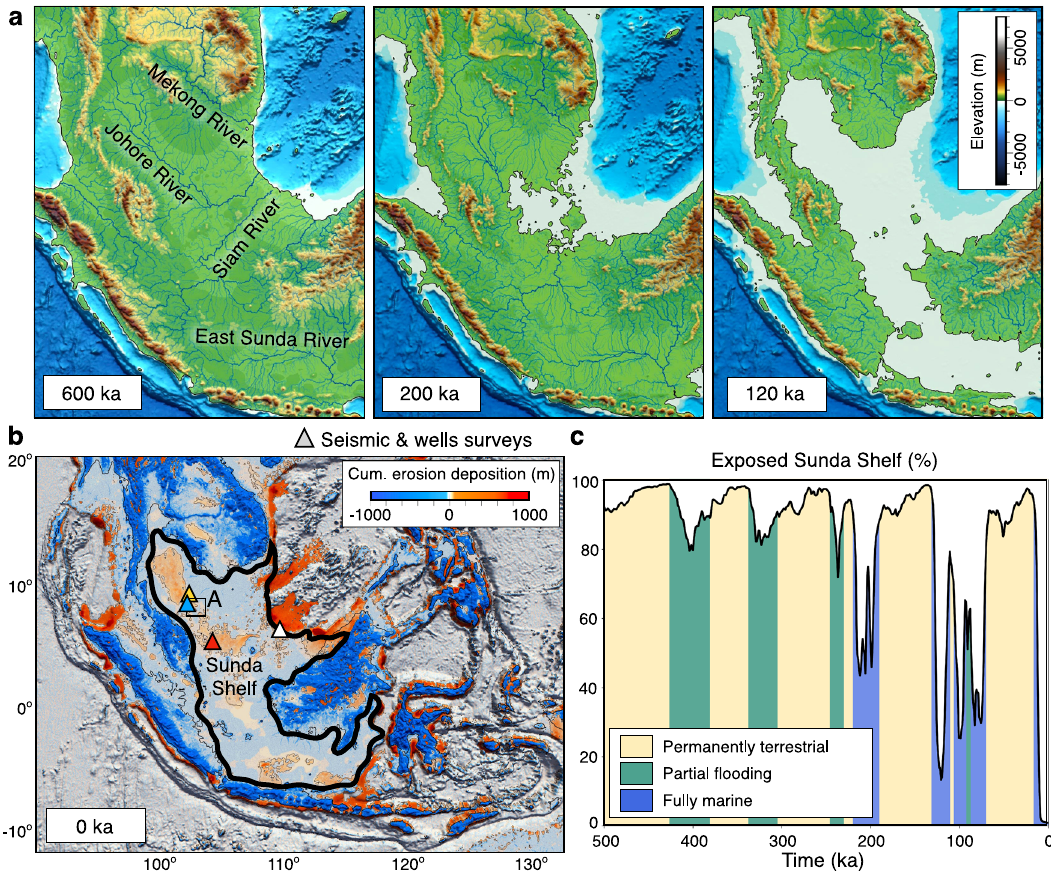
Fig. 1 Simulated landscape evolution, sedimentation and Sunda Shelf fl ooding history under tectonic, eustatic and rainfall forcing conditions. a Outputs showing simulated physiography changes for scenario 5 (Supplementary Table 2) induced by spatially variable tectonics (Supplementary Fig. 1b), eustatic (sea level 37 ) and atmospheric (precipitation 40 ) forcing. b Sunda shelf extent prior to 400 ka is delineated by the black contour. Cumulative erosion (blues) and deposition (reds) map obtained after calibration of landscape evolution parameters from subsurface data (seismic surveys and boreholes 41 – 44 , see Methods). c Subaerial exposure of the shelf is calculated at each time interval by computing the ratio between exposed area and Sunda shelf area prior to 400 ka. The shelf alternates three settings: exposed (>80%), partially fl ooded (>50%), and fully marine periods coloured in yellow, green and blue,